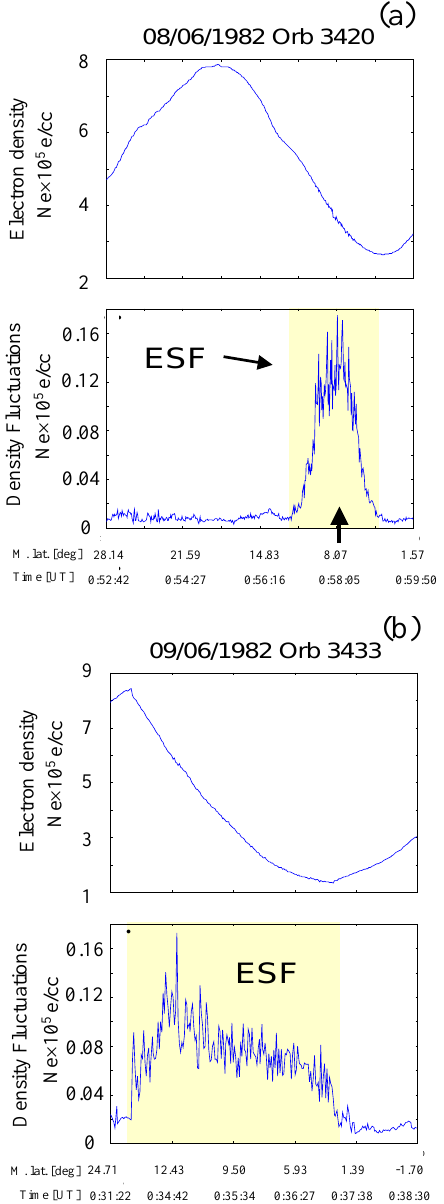
Fig. 1. Latitudinal variations (geomagnetic latitude) of the electron density along the Aureol-3 equatorial pass for two different days (top panels) and relevant RMS amplitude normalized by ambient electron density indicating the density fluctuations (bottom panels). Time in UT is also indicated along with geomagnetic latitude. The arrow in ( a ) indicates the time when the power spectral density in Fig. 2 is taken.